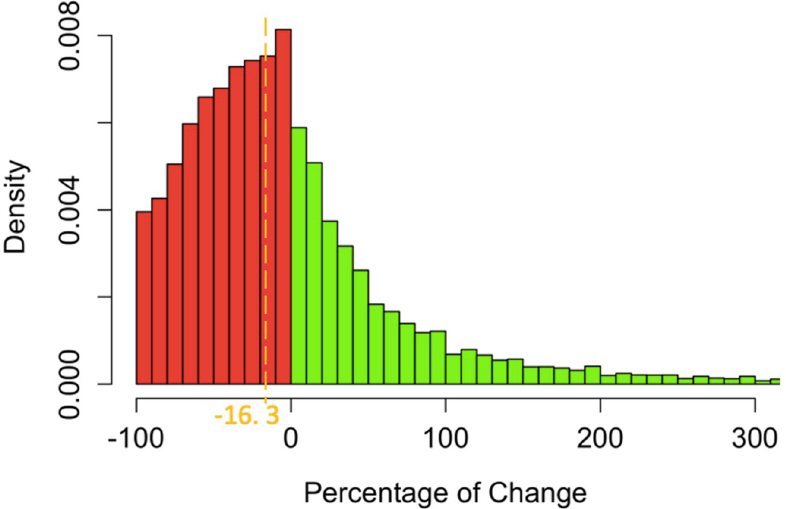
Fig 4. Density distribution of percentage of change in the number of trips per year from one year to another. Percentages are computed for each user that remained active for at least 3 years. The orange dashed line indicates the median decrease of long term users over a